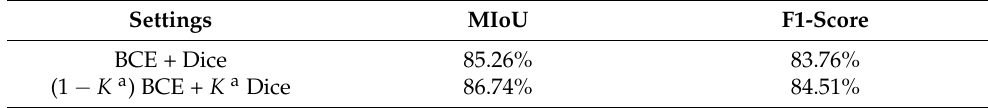
Figure 6. Comparison experiments of different values of the hyper-parameter K of the proposed MSPNet, evaluated by F1-score and MIoU metrics. Table 2. Performance and parameters comparison of ResNet series